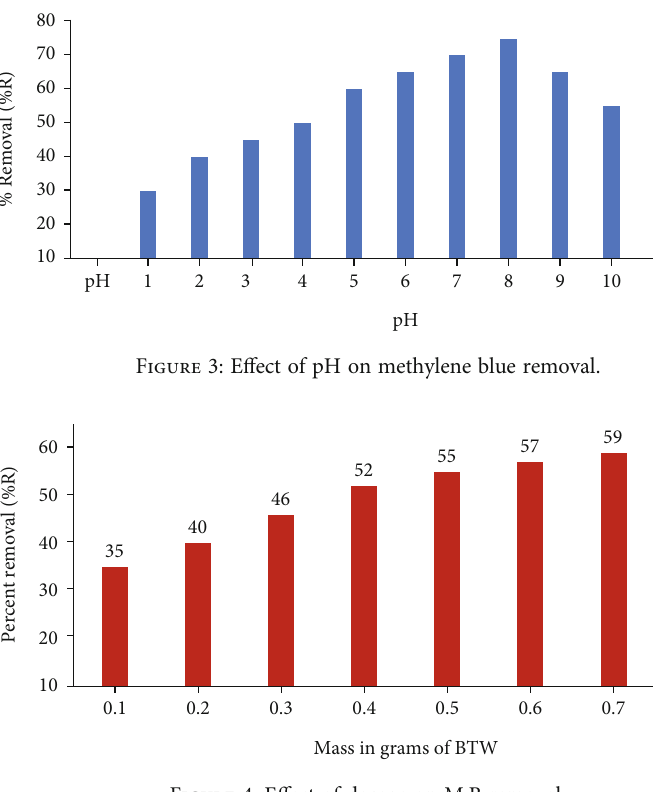
Figure 4: E ff ect of dosage on M.B removal.